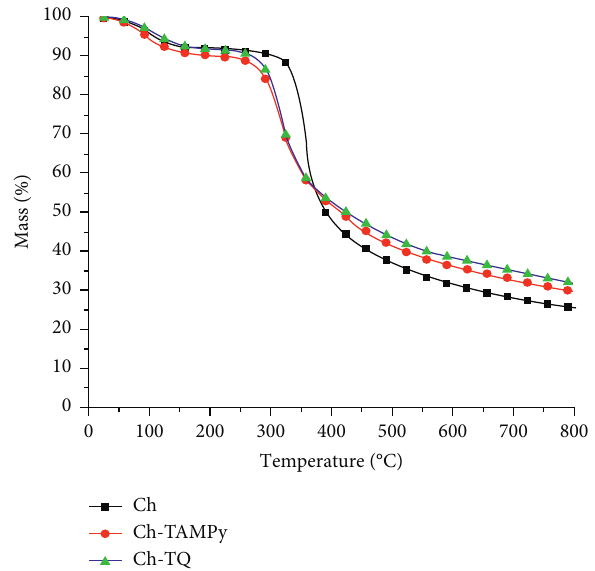
Figure 1: TGA degradation curves for Ch, Ch-TQ, and